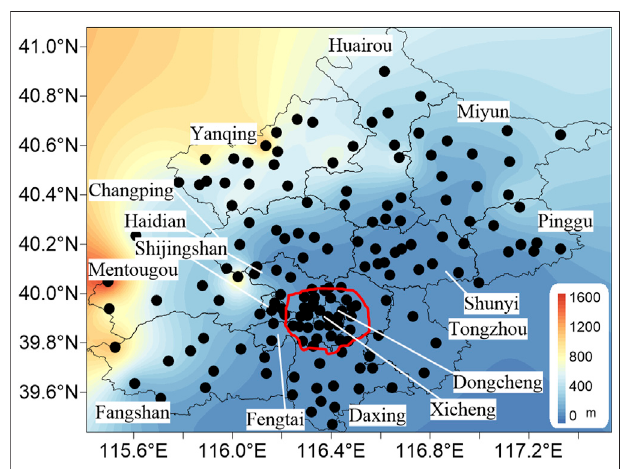
FIGURE1| Thedistributionof16districtsandstationsinBeijing.Thered line indicates the Fifth Ring